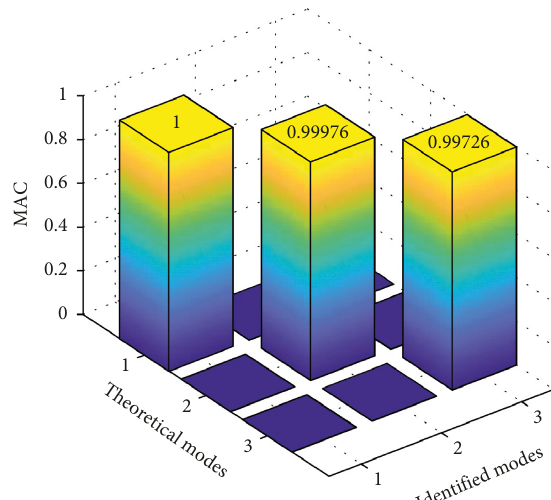
Figure 10: MAC of Cov-SSI results. (a) CoV-SSI (SNR �